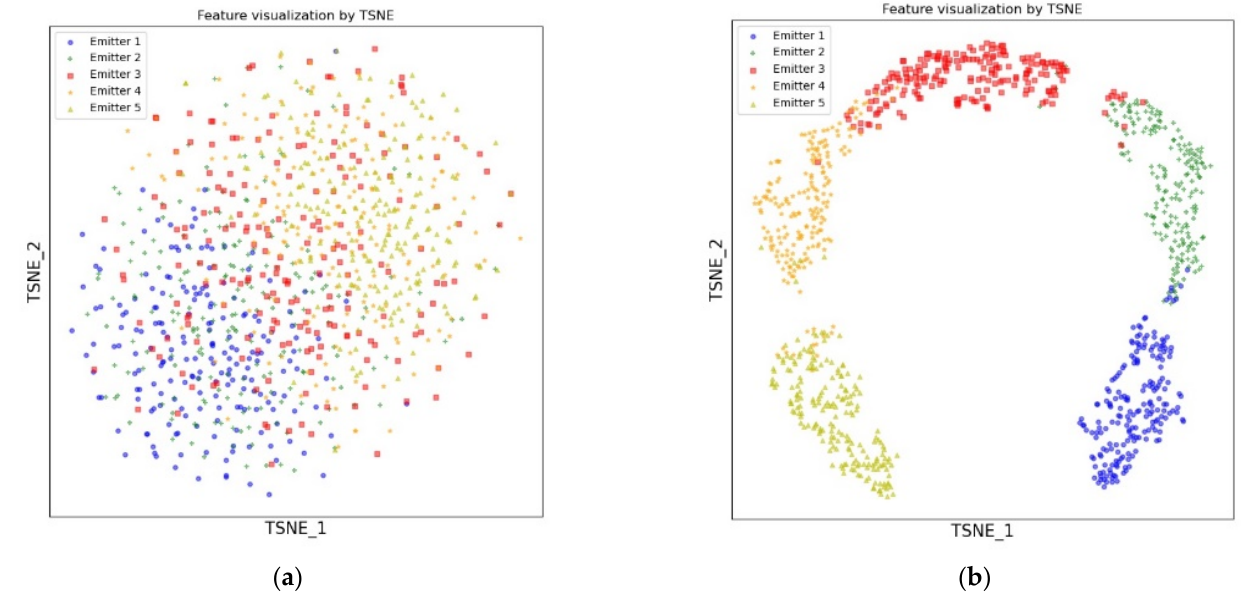
Figure 7. T ‐ SNE visualizations. ( a ) The output of Encoder without pre ‐ training; ( b ) The output of Encoder with pre ‐ training.